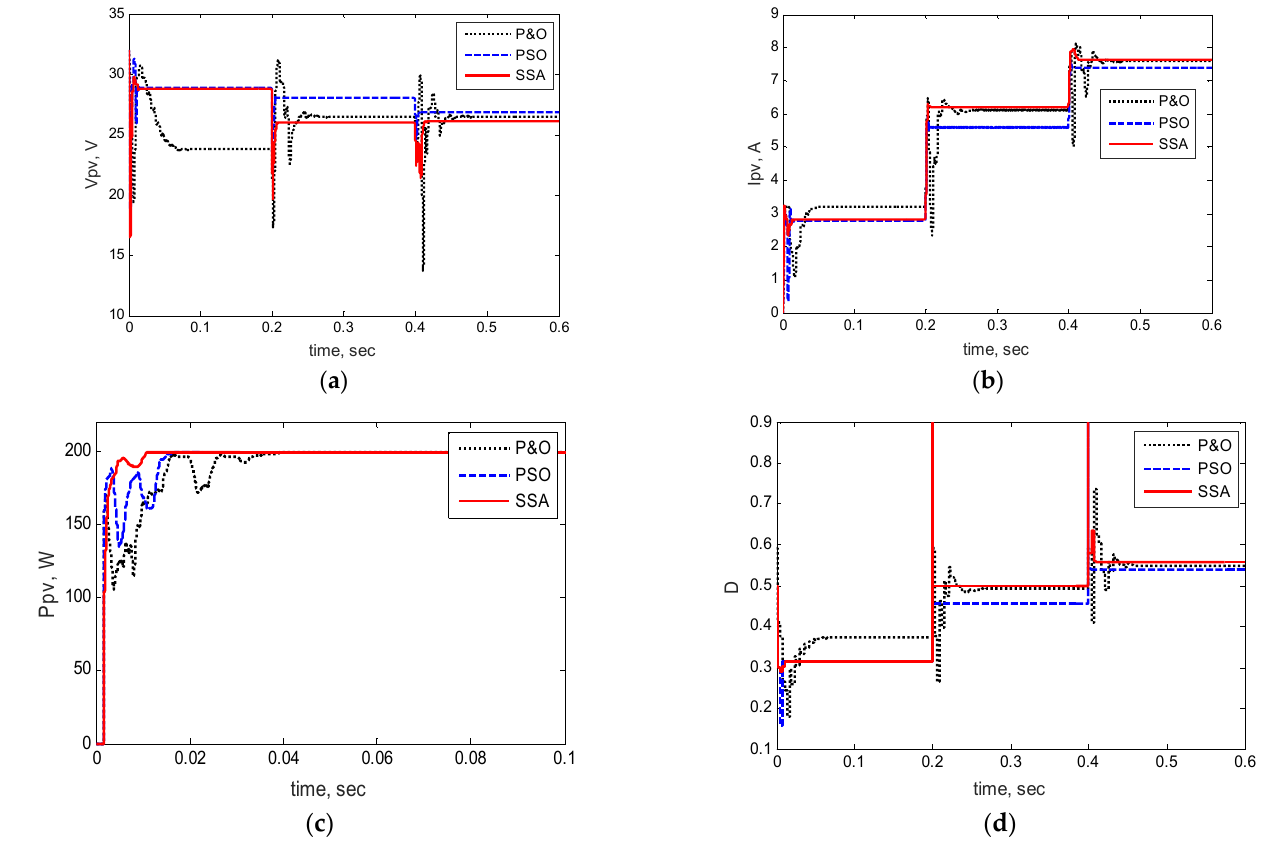
Figure 9. Photovoltaic panel tracking curves using the proposed method and the P&O and PSO methods in variable temperature conditions: ( a ) Vpv, ( b ) Ipv, ( c ) Ppv, ( d ) duty cycle.